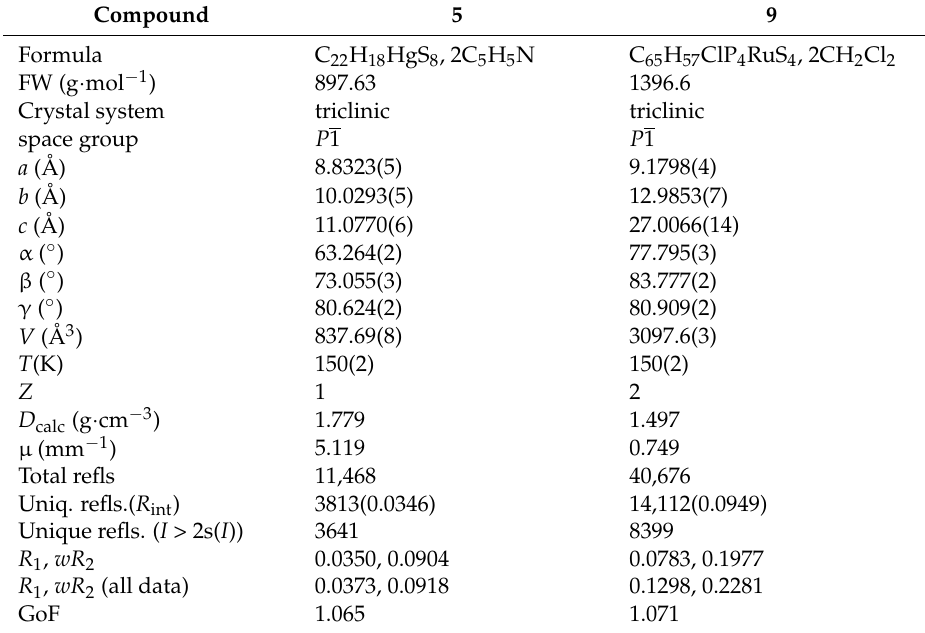
Table 4. Crystalloraphic data for complexes 5 and 9